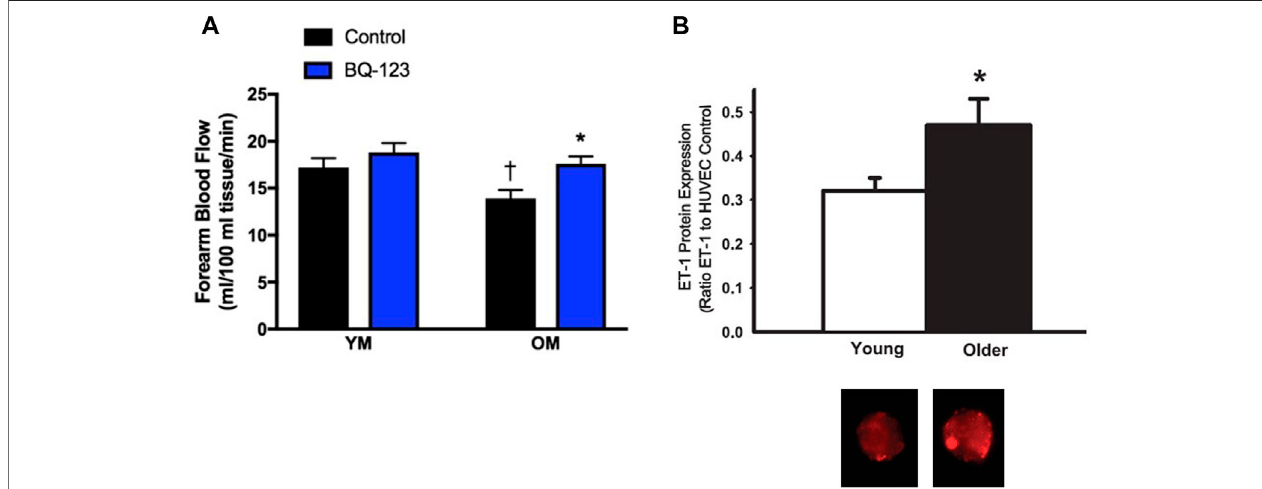
FIGURE 3 | ETA-mediated vasoconstriction and increased cellular expression of ET-1 contributes to age-related declines in endothelial function in men. Forearm blood fl ow responses to acetylcholine were measured in young men (YM) and older men (OM) during saline conditions (control; black bars) or co-infused with the ETA receptor antagonist BQ-123 (blue bars). The age-associated decline in endothelial function was abolished with co-infusion of BQ-123 (A) Graph from Stanhewicz et al. (2018);datafromWestbyetal.(2011).EndothelialcellularexpressionofET-1(asaratioofET-1toHUVECcontrol)collectedinhealthyyoungandoldmen. (B,top) and representative images of venous endothelial cell ET-1 expression obtained from brachial arteries in a young and older man (B, bottom) Data from Donato et al. (2009)).